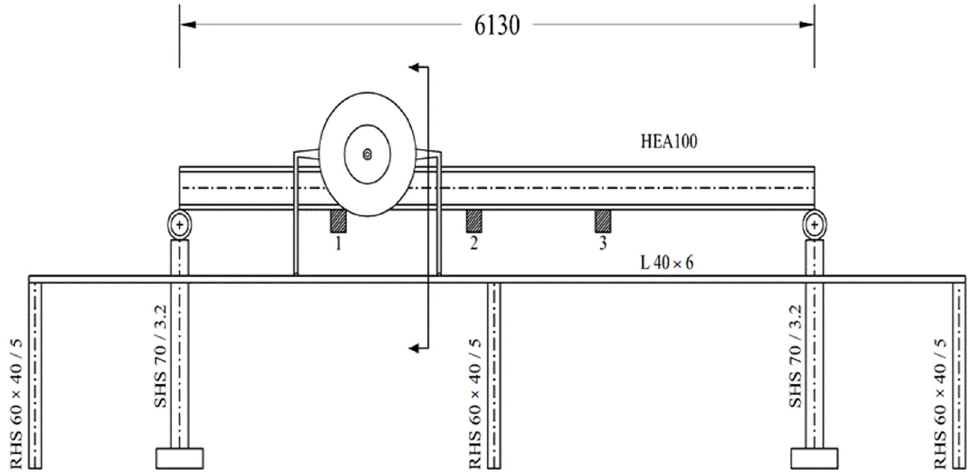
Figure 1. Experimental setup for a simply supported girder of length L = 6130 mm under a heavy mass moving with constant speed and accelerometers placed at L /4, 7 L /16 and 2 L /3. Note: The undercarriage acts as a railguide for the moving